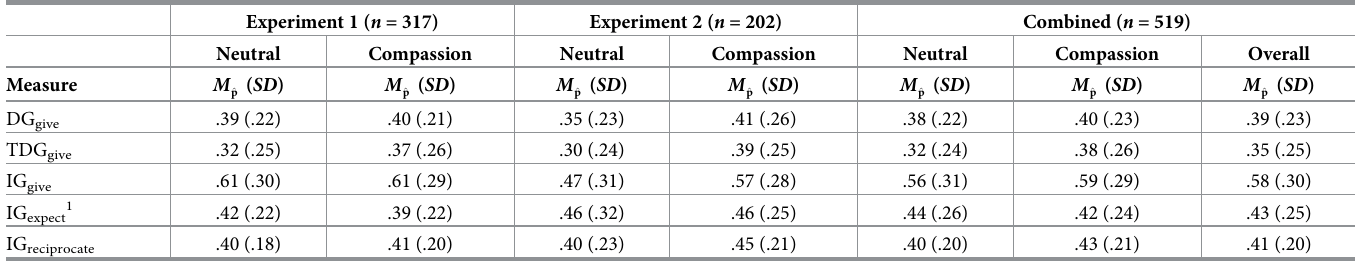
Table 1. Descriptive statistics of economic decisions by experimental